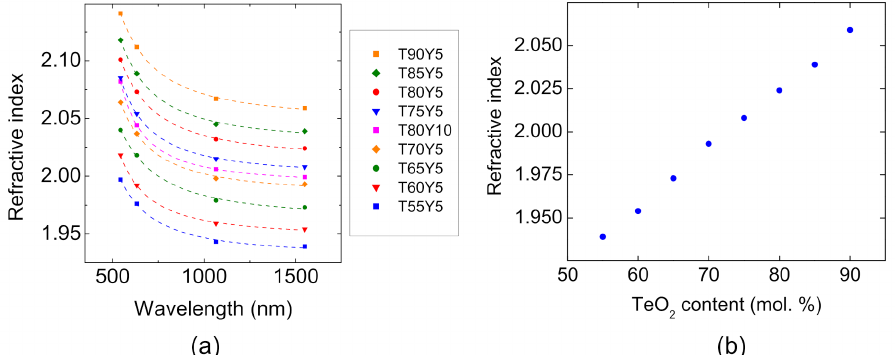
Figure 4. ( a ) Refractive indices of the glasses considered in this work measured at 543.3, 632.8, 1064 and 1550 nm. The curves in dashed lines correspond to the Sellemeier fit of the experimental values. ( b ) Compositional dependence of the refractive index measured at 1550 nm.